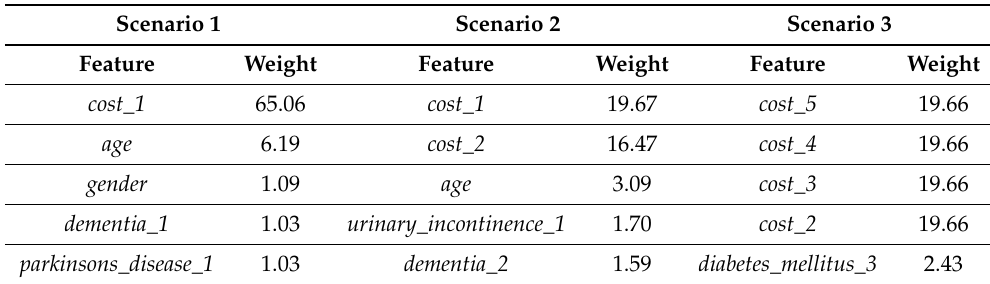
Table 7. Top 5 features for each scenario.